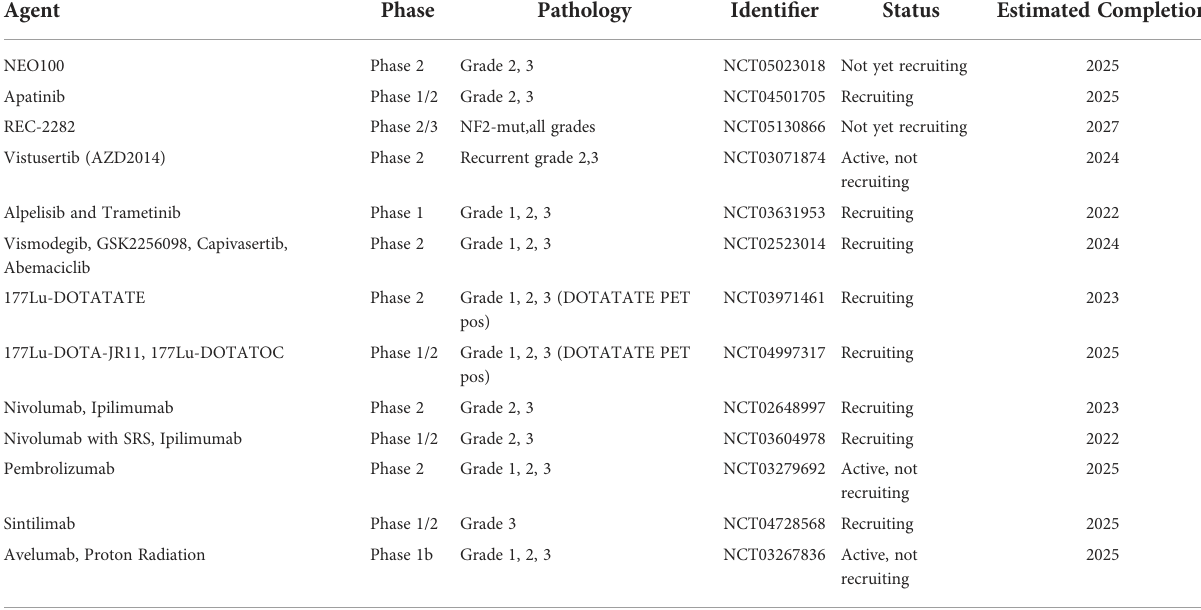
TABLE 3 Current clinical trials investigating medical therapies for